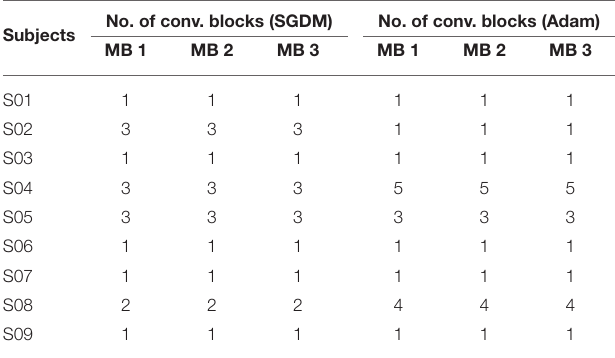
TABLE 2 | Design Parameters for Architecture-2 for inter-subject transfer learning. Layers